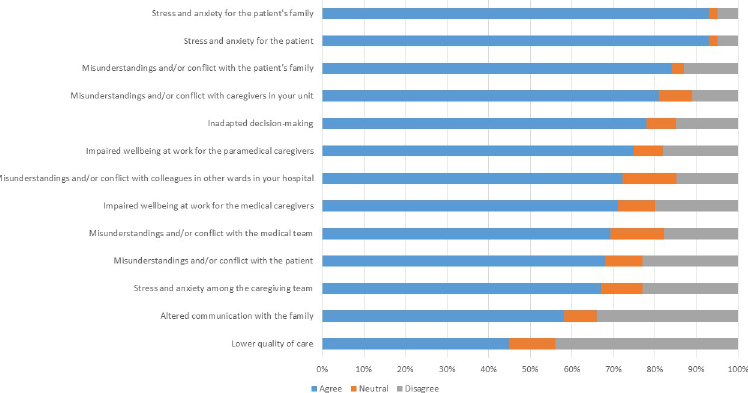
Fig 3. Level of reported agreement with the different possible consequences of a “non-beneficial” stay in the ICU (Domain 3 of the questionnaire).